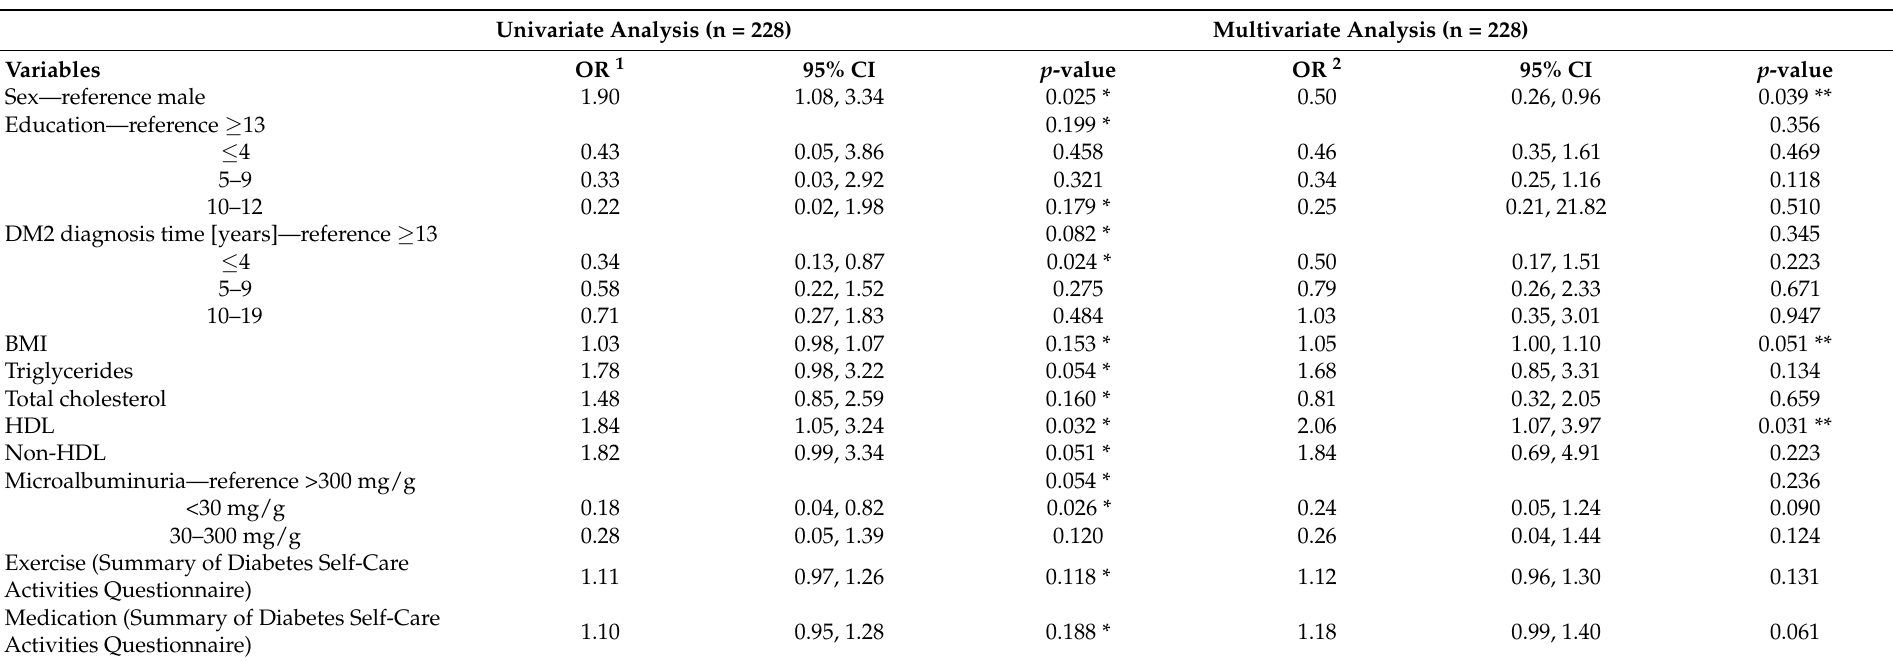
Table 2. Univariate and multivariate binary regression analysis of variables (socioeconomic, clinical, health, and self-care habits) associated with diabetic neuropathy. Univariate Analysis (n = 228) Multivariate Analysis (n =